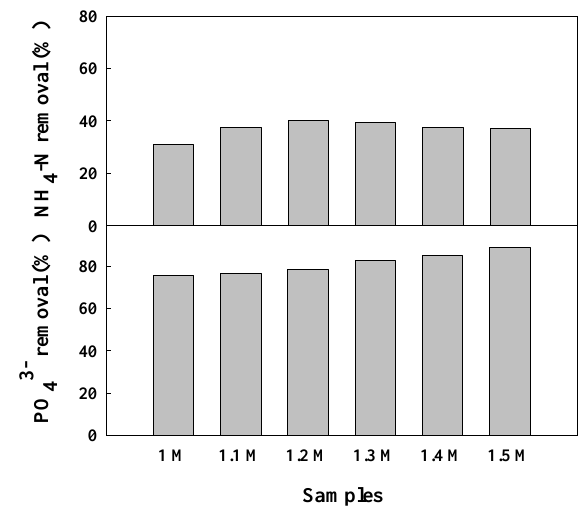
Figure 2. Effect of mixing time on the struvite crystallization of anaerobic digestive fluid of swine manure. * This experiment was done at 200 rpm for 1 h; others (without asterisk) were done at 100 rpm for 10 min, 1 h, and 24 h.